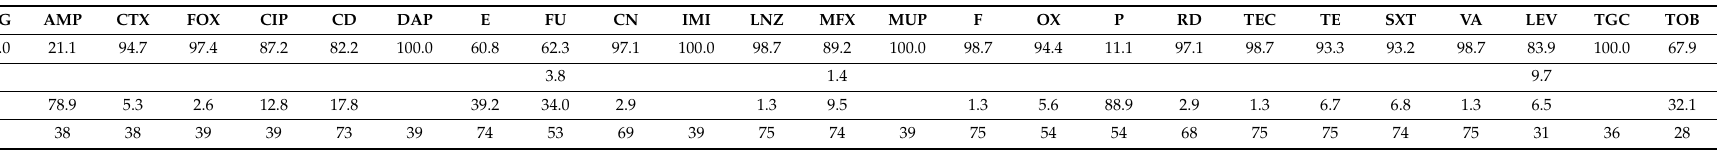
Table 2. Percentage susceptible, resistant, and intermediate methicillin-susceptible Staphylococcus aureus isolates across 26 different antimicrobials in Ha’il, Saudi